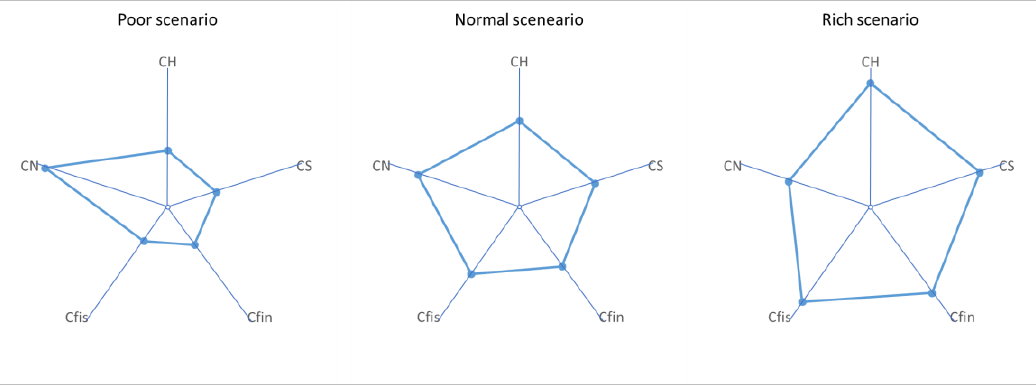
Figure 1. Assets Pentagon Scenarios, presented by [22].